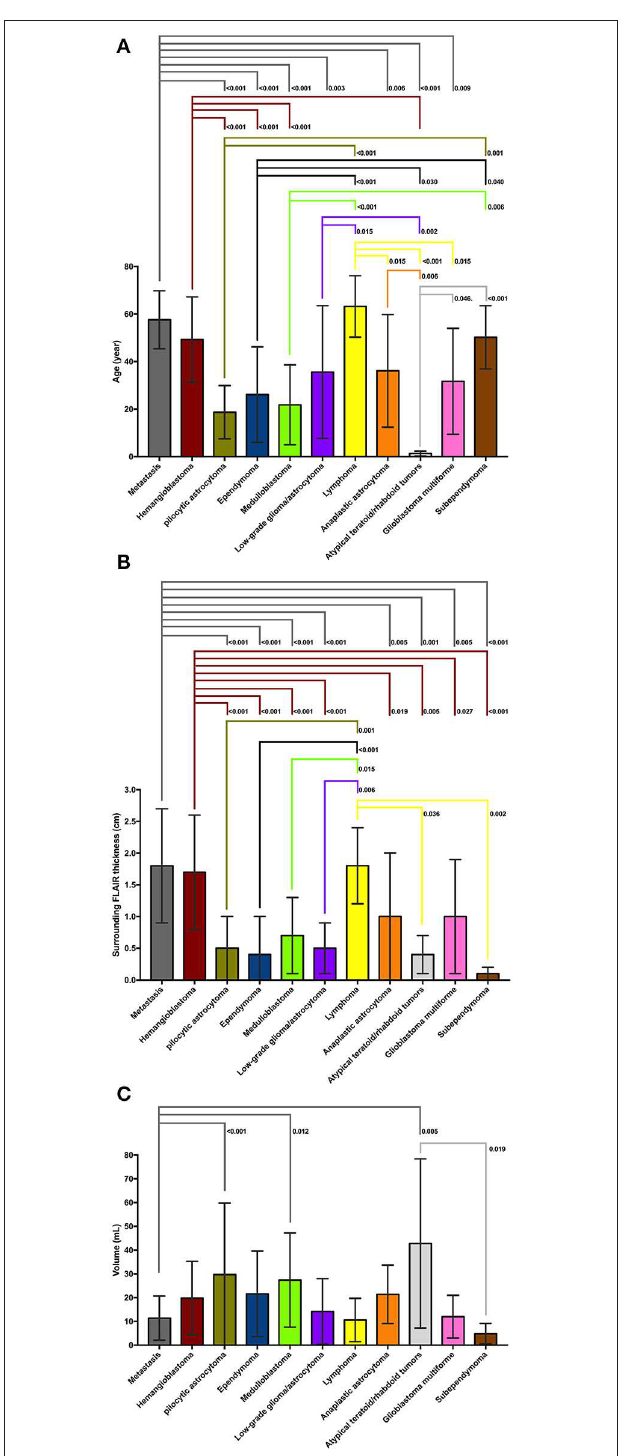
FIGURE 3 | (A) On post-hoc analysis, patients with atypical teratoid/rhabdoid tumors (ATRT) had significantly lower age at presentation compare to all other tumor types except medulloblastoma and pilocytic astrocytoma. Patients with medulloblastoma, pilocytic astrocytoma, and ependymoma were significantly younger compared to those with metastasis, lymphoma, hemangioblastoma,